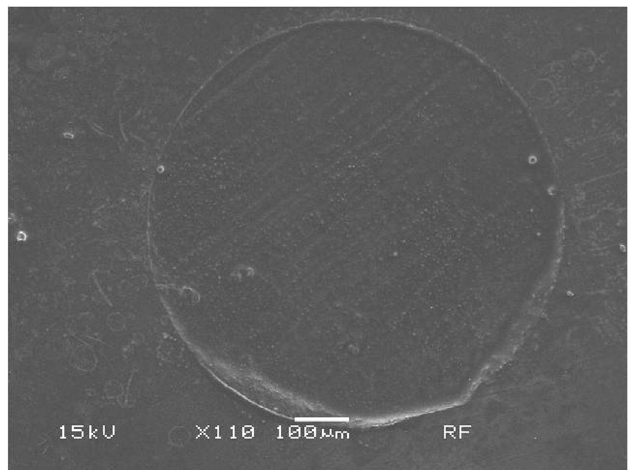
Fig. 5 - SEM photomicrograph illustrating an adhesive failure along the dentin for RelyX